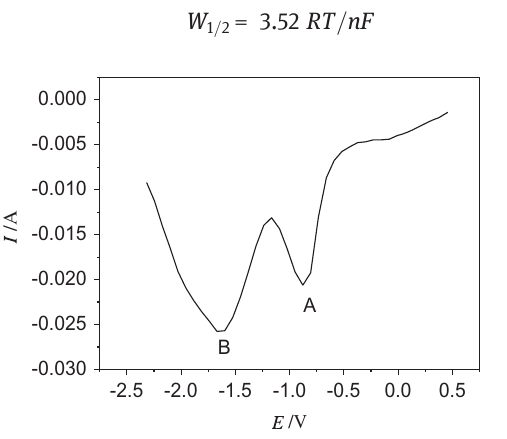
Figure 3: Square wave voltammogram on a Fe electrode in NaCl-NaF- KCl-SiO 2 ( c SiO2 = 0.177 mol·L − 1 ) melt at 1,103 K. Pulse height: 180 mV, potential step: 72 mV, and frequency: 20